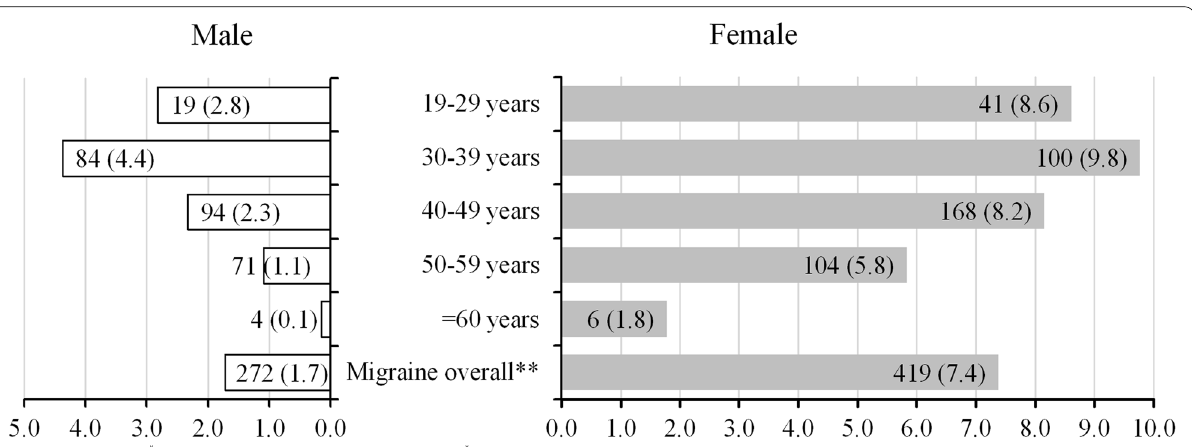
Fig. 4 Prevalence * of migraine stratified by sex and age†. * Number and percentage with the number of same age and sex category was used as a denominator. ** Number of migraine overall in male is 272 and female is 419. † Refer the summary of number of patients for each sex in Table